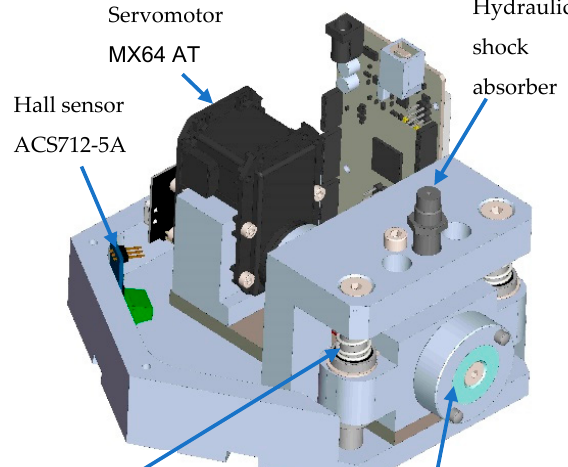
Figure 4. Modular mobile robot with two conventional wheels (real model). ( a ) Isometric view. ( b ) Bottom view.